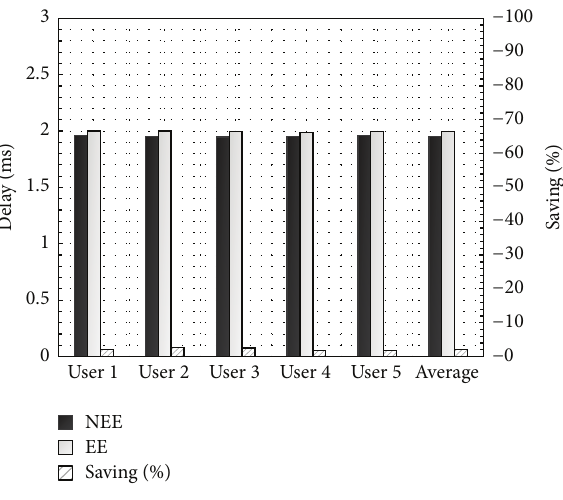
Figure 4: Power consumption with 𝑆 = 3, 𝑁 = 5.